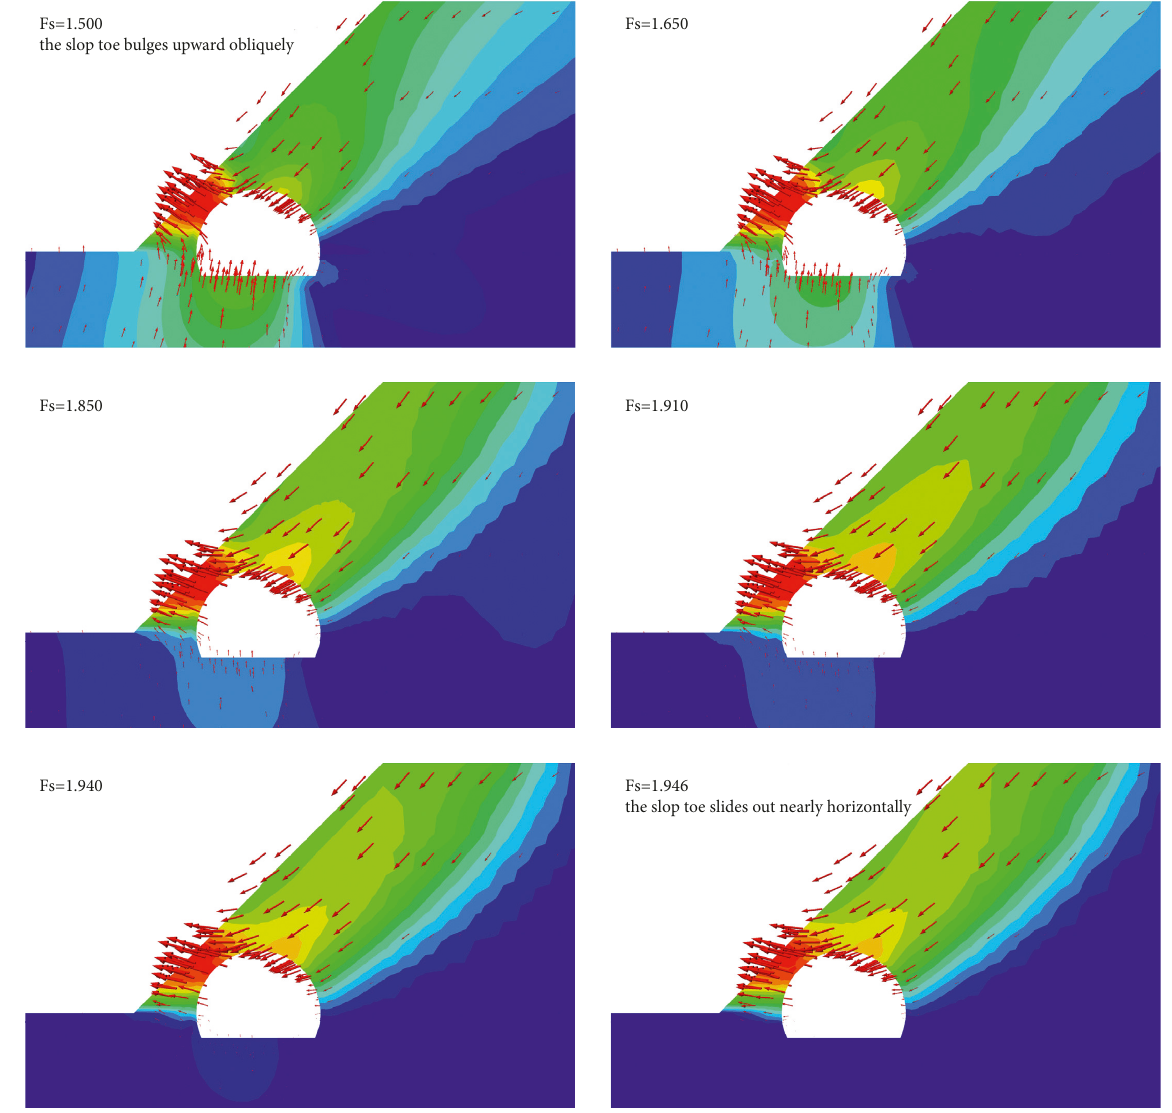
Figure 11: Displacement cloud diagram of the tunnel slope and its moving